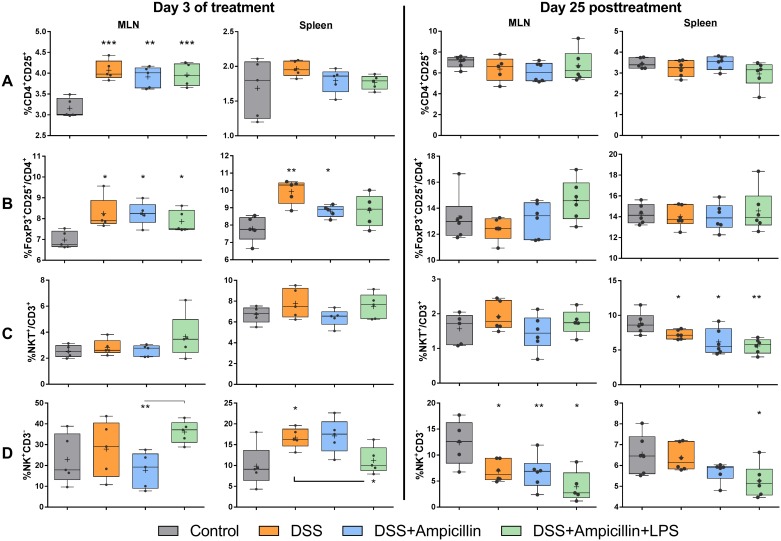
Immune cell flow cytometry.Flow cytometric analysis of cells isolated from mesenteric lymph nodes (MLN) and spleen in mice during and 25 days post-treatment with 1.5% dextran sulfate sodium (DSS), 1g/L ampicillin and/or diet containing 40.8 mg/kg lipopolysaccharides (LPS). Percentages of CD4+CD25+ activated T helper cells present among all lymphocytes (A), FoxP3+ Treg cells among CD4+ T cells (B), NKT+ among all T cells (C) and NK cells among all lymphocytes (D) are shown. Box and whisker plots, + shows mean; whiskers: min.-max., n = 5–6 per group as shown by dots (p-values: * = p<0.05; ** = <0.01; *** = p<0.001, no line: compared to control group).